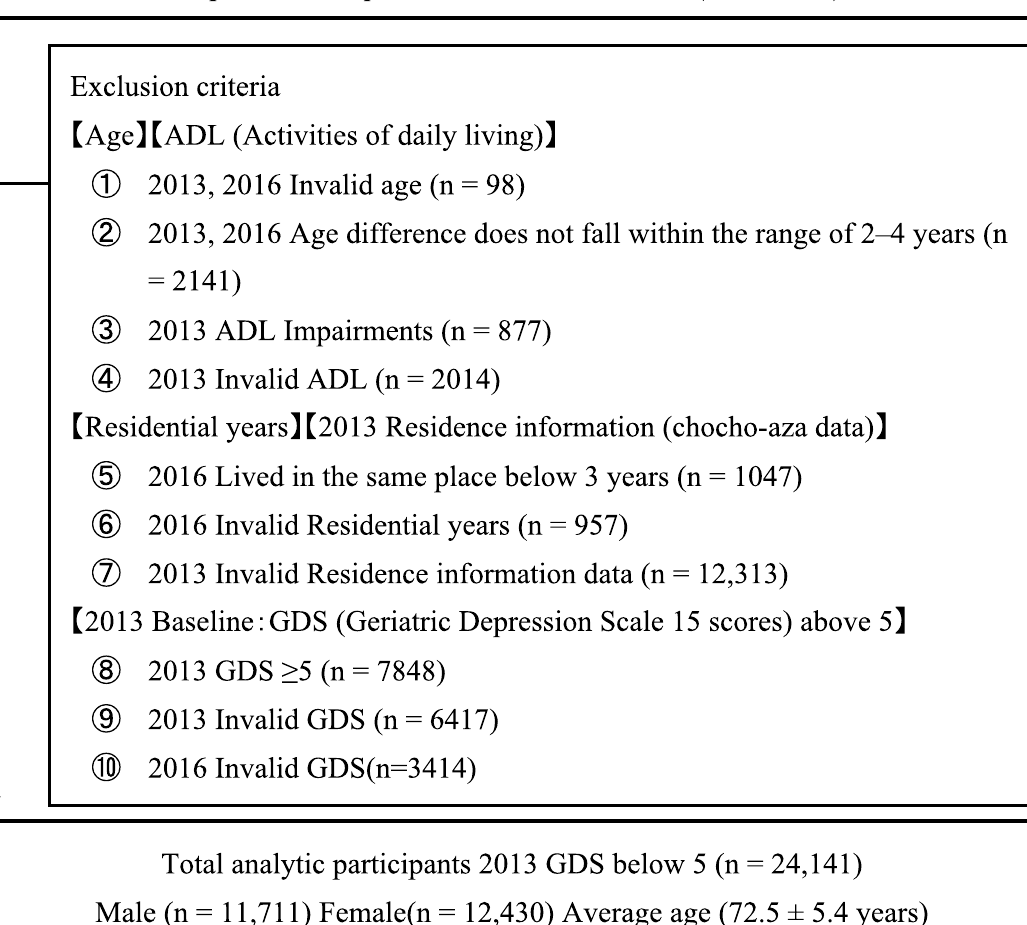
Figure 1. Flow of participants in the